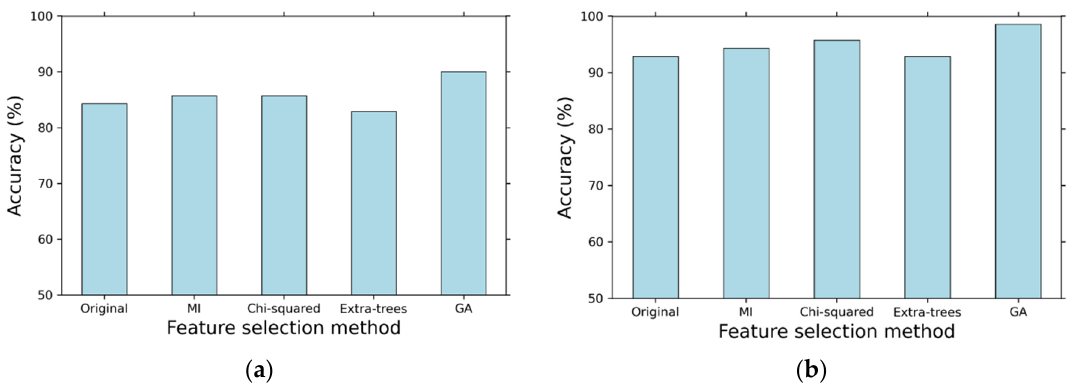
Figure 5. Comparison analysis of several feature selection methods on the XGBoost model accuracy for dataset ( a ) I (multi-class), and ( b ) II (binary-class).